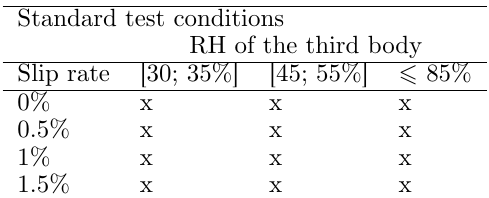
Fig. 8. Illustration of placement of leaves used during the tests reported in Table 4. Table 4. Summary of test conditions.